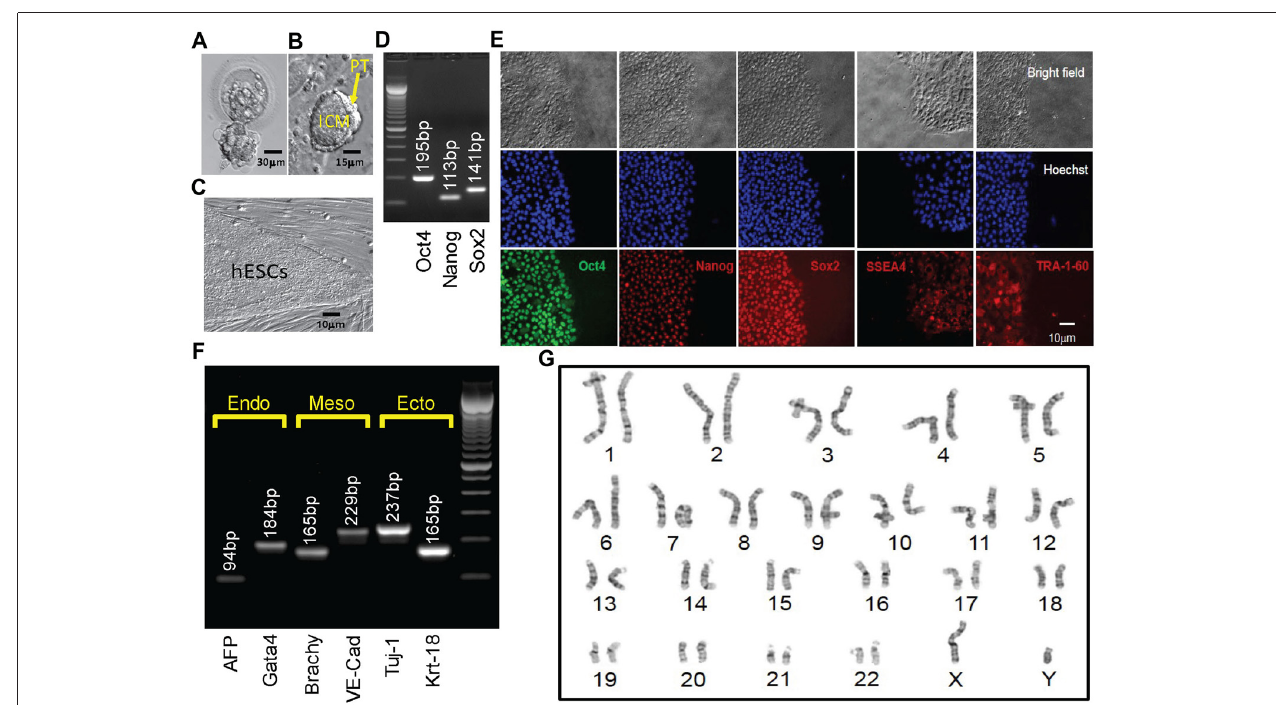
FIGURE 3 | Derivation, expansion and characterization of Fragile X-disease specific human embryonic stem cell (hESC; vFrag-X-ds-hESC; UM139-2 PGD) line. (A) Human blastocyst with FMR1 expansion that was cryopreserved, donated, shipped and warmed prior to attempting hESC derivation. Scale bar represents 30 µ m. (B) The inner cell mass (ICM) with surrounding polar trophectoderm (PT) was laser-dissected from the blastocyst and plated/attached on human foreskin fibroblast (HFF). This micrograph represents the early Frag-X-ds-hESC colony before the first passage, 5 days after laser-dissection and plating of the ICM/PT (P0D5). Scale bar represents 15 µ m. (C) Expanding undifferentiated Frag-X-ds-hESCs with tight colony borders on a HFF feeder layer (P3D3). Scale bar represents 10 µ m. (D) Undifferentiated Frag-X-ds-hESCs expressed pluripotency markers (Oct4, Nanog, Sox2) as assessed by qPCR. Electrophoresis demonstrated anticipated amplicons for each pluripotency marker PCR primer sets. (E) Expanded undifferentiated Frag-X-ds-hESCs with tight colony borders on Martigel (brightfield micrographs) expressed pluripotency marker proteins in the nucleus (same location as Hoechst staining; Oct4, Nanog, Sox2) or cytoplasmic/cell membrane associated (SSEA4 and TRA-1-60). (F) Frag-X-ds-hESCs were differentiated into embryoid bodies for 21 days in culture. Differentiated Frag-X-ds-embryoid bodies expressed linage marker RNA of endoderm [ α -fetoprotein (AFP) and GATA4], mesoderm [brachyury (Brachy) and VE-Cadherin (VE-Cad)] and ectoderm [neuron-specific class III beat-tubulin (Tuj-1) and keratin-18 (Krt-18)] with anticipated amplicon size by electrophoresis for each linage marker PCR primer set. Scale bar represents 10 µ m. (G) Passage 6 undifferentiated Frag-X-ds-hESCs were sent to Cell Line Genetics (Madison, WI, USA) for G-B and karyotyping and reported to be a 46XY, euploid hESC